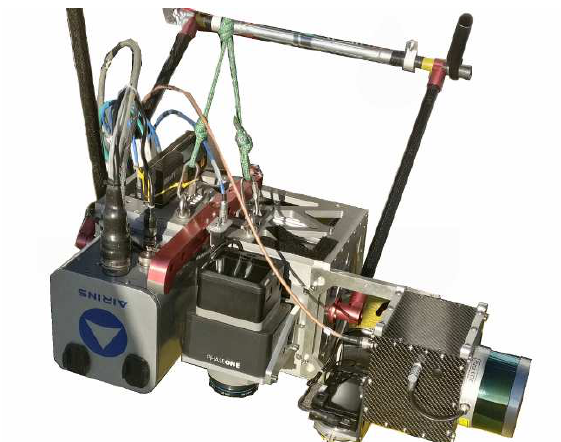
Figure 1: Assembly of 3 IMU’s, 2 LiDARs and 2 cameras.